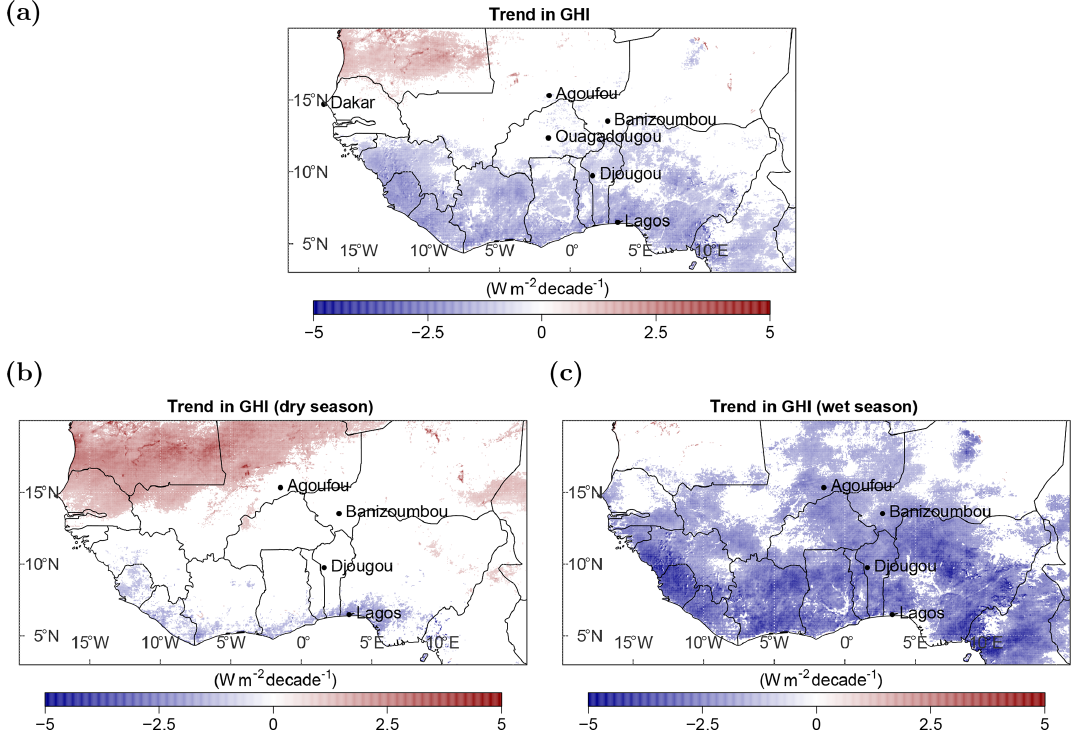
Figure 9. Linear trend for the annual mean global irradiance (a) and the global irradiance in the dry (b) and wet seasons (c) for all significant cases (based on the 95% confidence interval). Ouagadougou (Burkina Faso) and Dakar (Senegal) are additionally visualized here, as values at these locations are compared within this